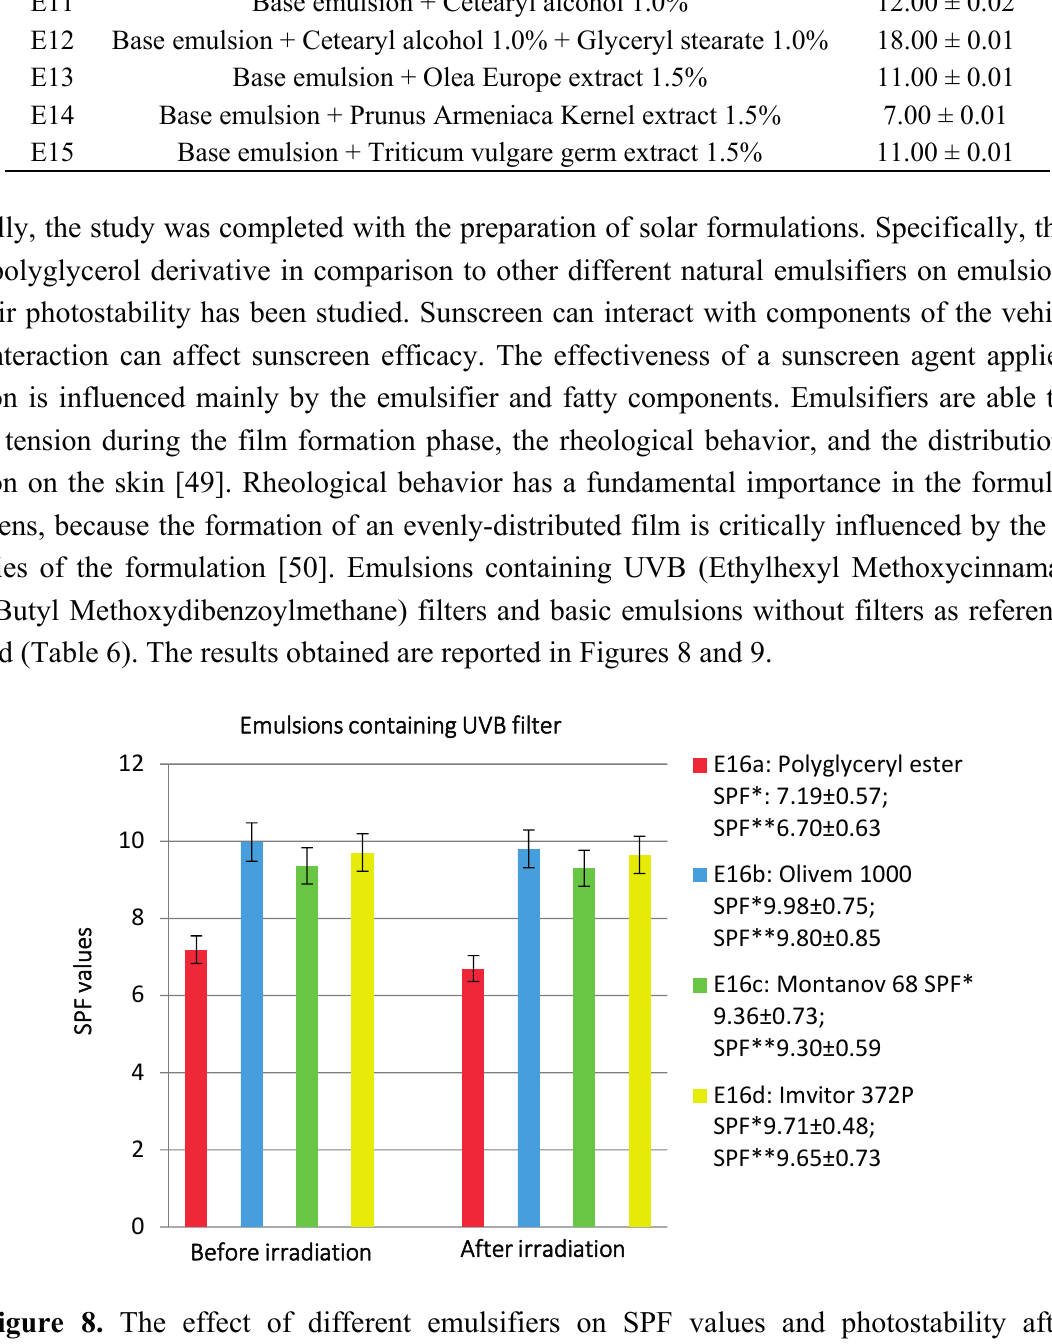
Figure 8. The effect of different emulsifiers on SPF values and photostability after irradiation at 20 MED of emulsions containing UVB filter. SPF *: SPF value before irradiation; SPF **: SPF value after